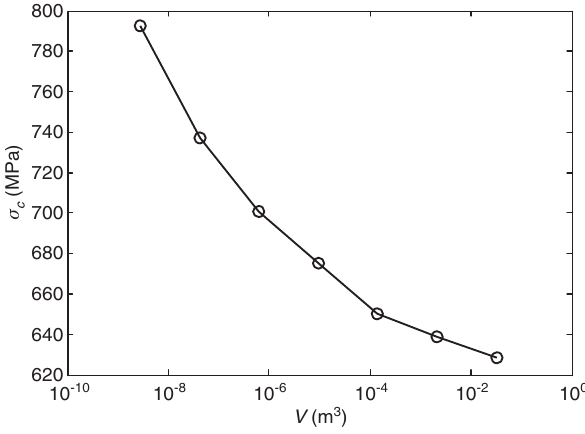
Figure 3: Variation of the longitudinal tensile strength with